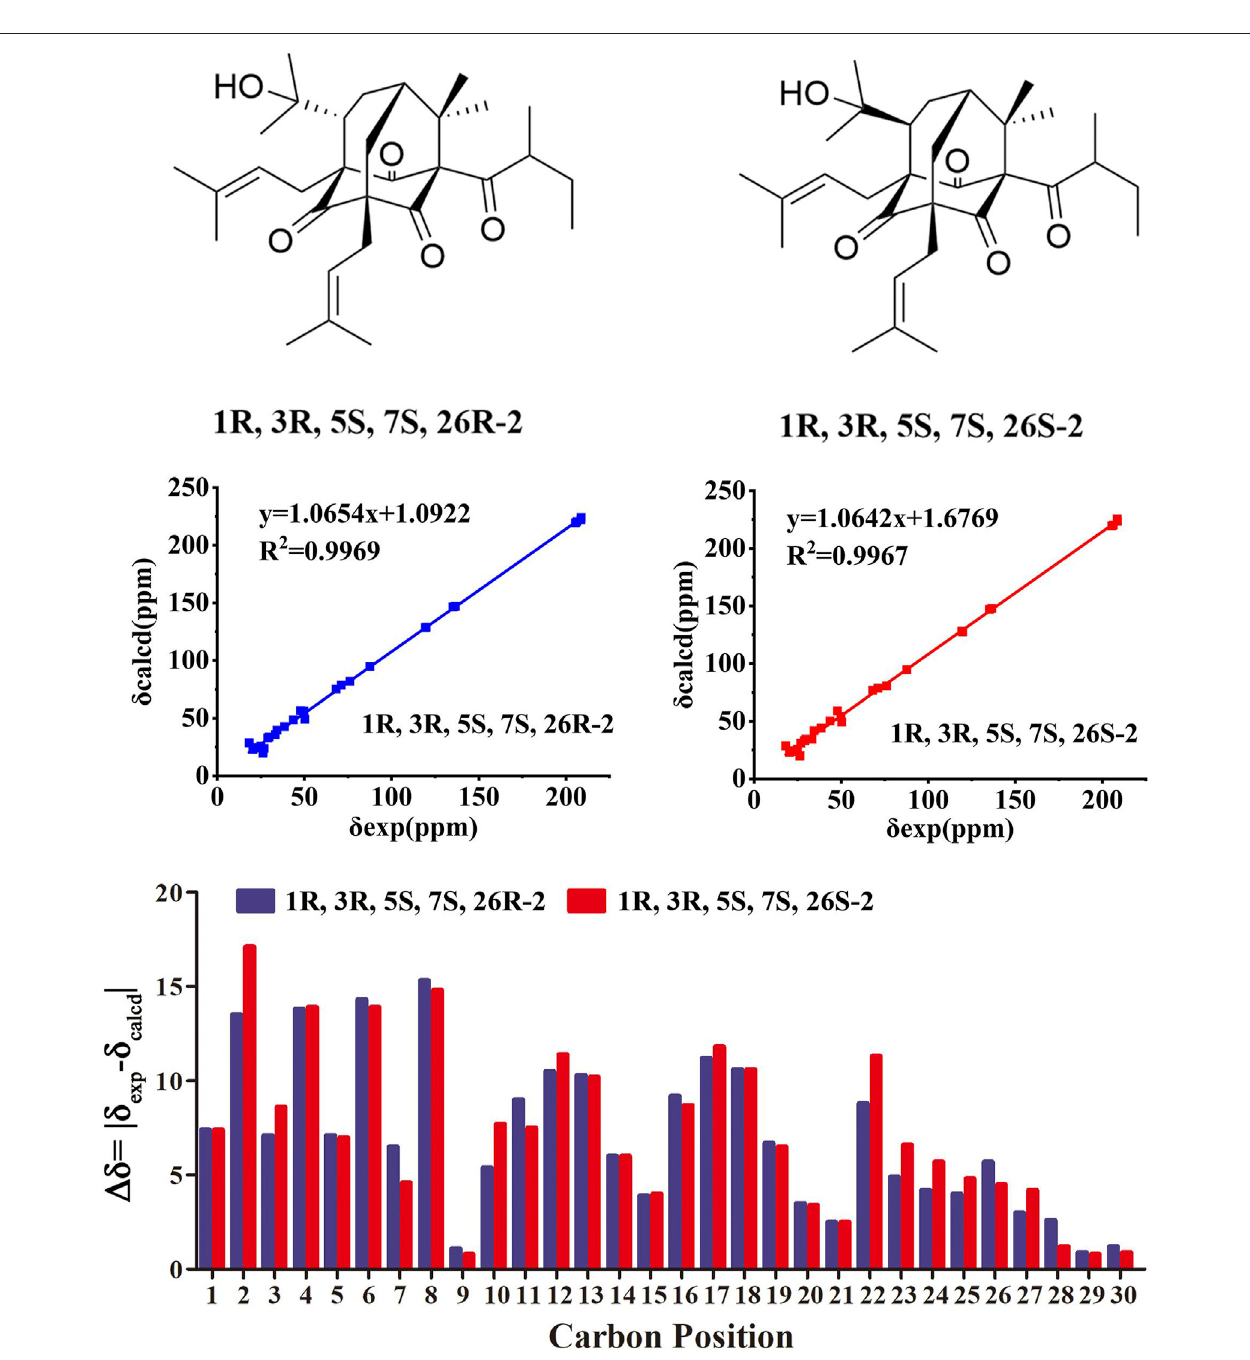
FIGURE 4 | NMR calculations of compound 2